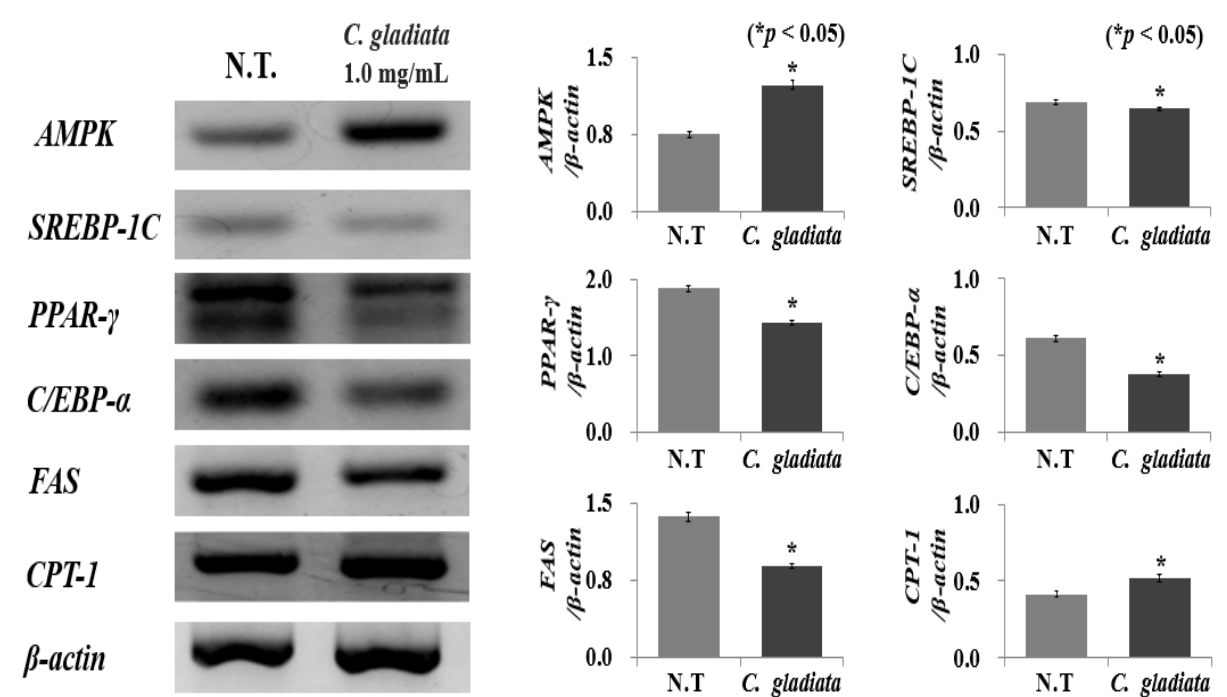
Figure 3. Effect of C. gladiata extract on AMPK , CPT-1 , SREBP-1c , PPAR- γ , C/EBP- α and FAS mRNA expression levels in 3T3-L1. Values are expressed as mean ± standard deviation of three experiments. Bars marked with asterisks are significantly different from the control (* p < 0.05).